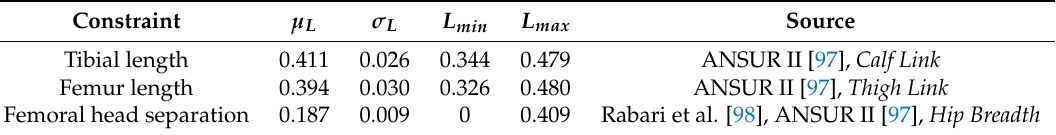
Table 2. Assumed mean and variance for anthropometric priors in the proposed model. All values in